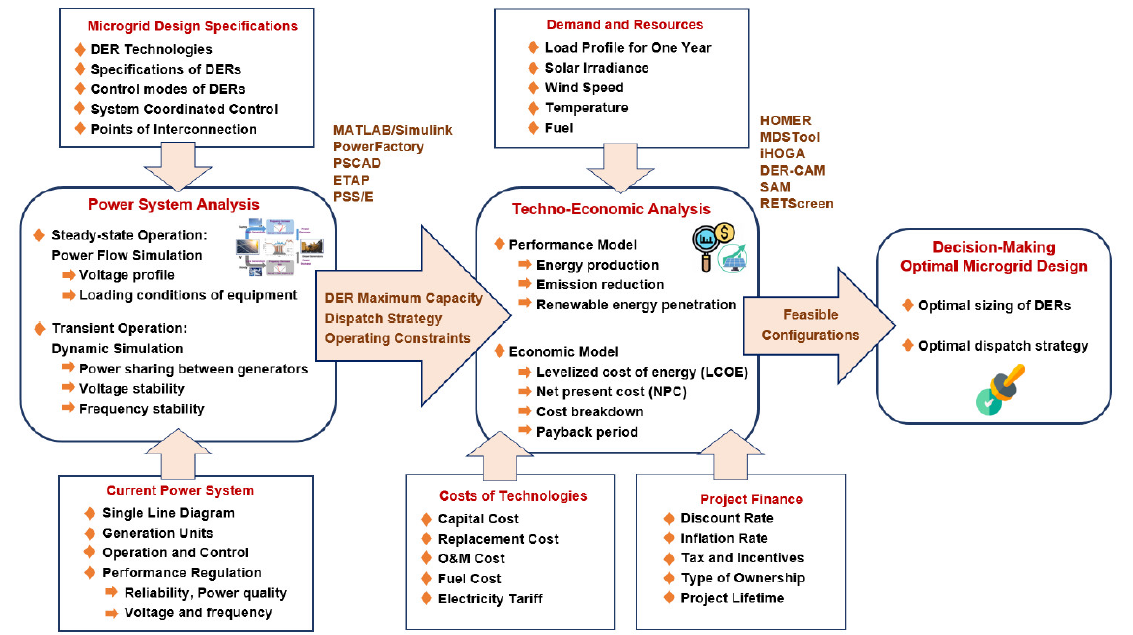
Figure 5. A MG design framework (from Figure 1 in [63])